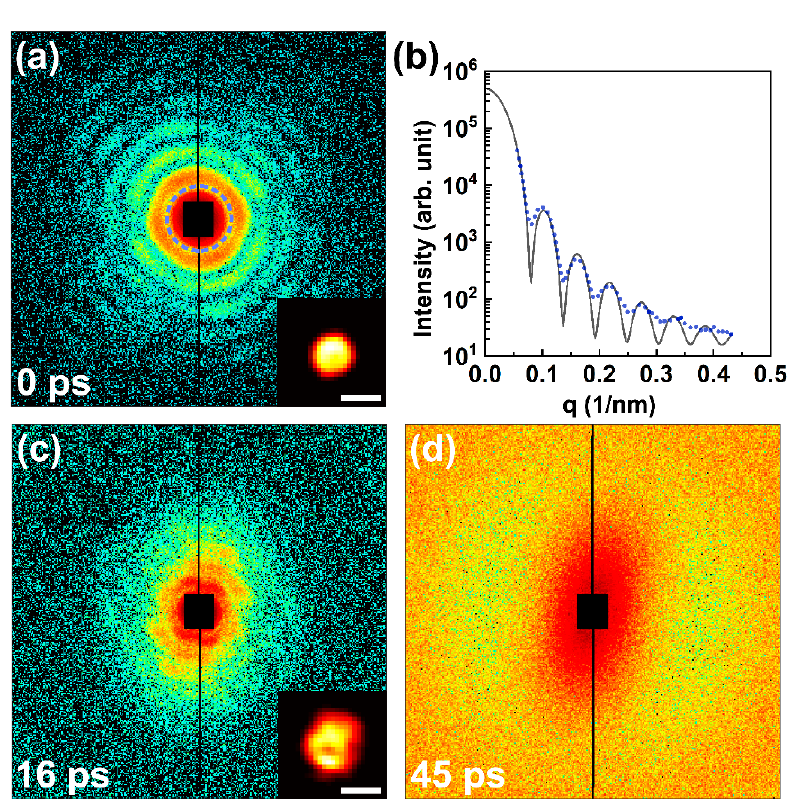
Figure 6. Diffraction patterns measured over a series of time delays showing the Ag nanoparticle melting process. Ag nanoparticles with a nominal diameter of 100 nm were melted by the IR laser ( λ = 800 nm, ~420 mJ/cm 2 fluence). The intact Ag nanosphere reconstructed from diffraction pattern measured at 0 ps time delay is shown in the inset of ( a ). The blue dashed circle of the diffraction pattern in ( a ) represents the size of the zeroth speckle. The q zeroth corresponding to the radius of this circle is 0.08 nm − 1 . ( b ) The sum of the radial intensity (blue dotted line) for the diffraction pattern of the intact Ag nanosphere is fitted to the sum of the radial intensity of the ideal sphere of the same size expected from Equation (1) (black line). ( c ) The measured diffraction pattern after a time delay of 16 ps shows the morphological transformation and expansion of the nanoparticles by the IR laser. The low-density void is shown in the reconstructed image (the inset of ( c )). The butterfly-shaped signal was measured after a 45-ps time delay ( d ). As there is no speckle at all, this signal indicates the complete destruction of the nanosphere. The length of scalebar corresponds to 100 nm.